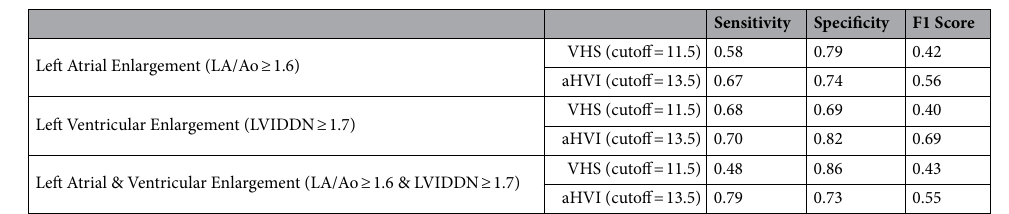
Table 5. Prediction performance comparison between VHS and aHVI.